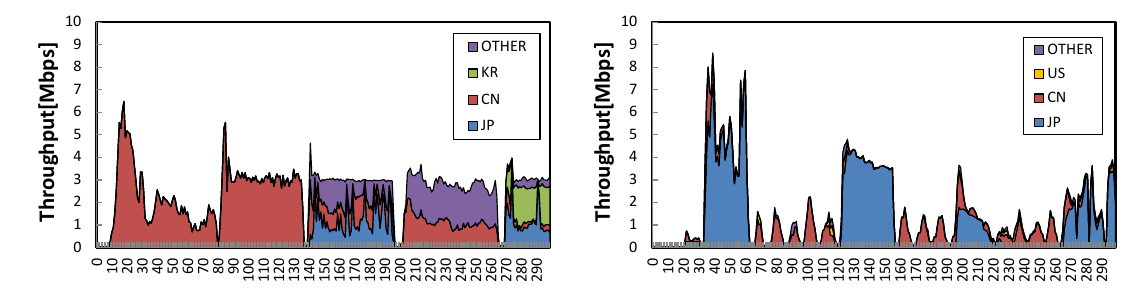
Fig. 5. Downloaded data and neighbor peer distribution by country for PPTV when forcing packet loss with different rate.